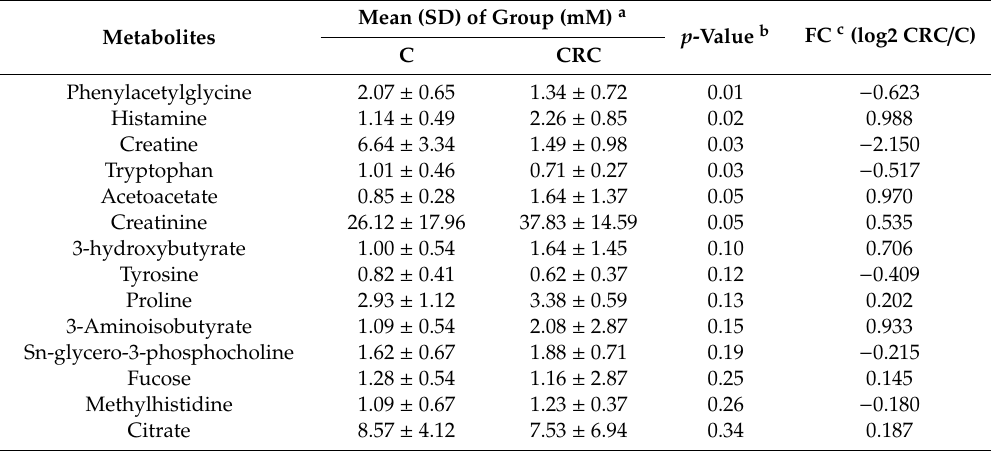
Figure 5. Receiver Operating Characteristic (ROC) analysis. Area under the curve (AUC) was found to be 0.879. CI: Confidence Interval. Table 2. Statistical di ff erences of metabolites characterized by Variable Importance for the Projection (VIP) >